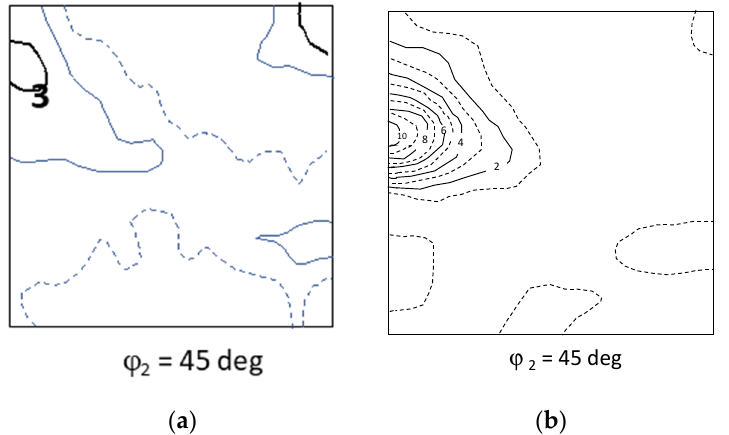
Figure 2. φ 2 = 45° sections of ( a ) Ti–IF steel and ( b ) Mn-alloyed Ti–IF steel after austenitic hot rolling, partially below the Tnr temperature. ODFs extracted from [15].